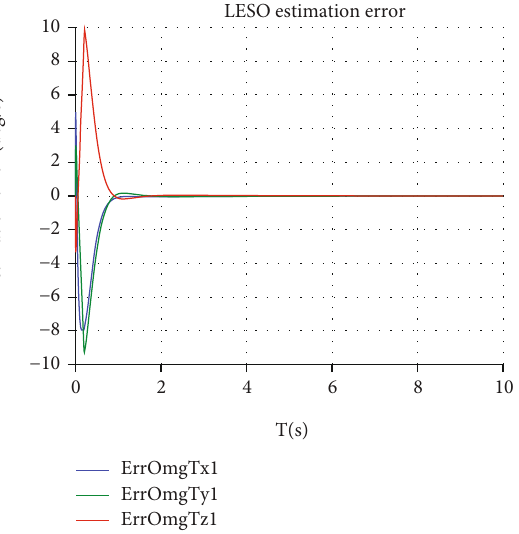
Figure 4: Variation of roll angle.